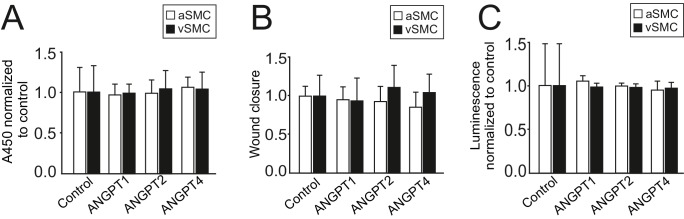
Smooth muscle cell proliferation, migration or apoptosis is not affected by ANGPT4.(A) ANGPT4 does not affect proliferation of aSMCs (n = 5 independent experiments) or vSMCs (n = 3) in BrdU ELISA. (B) ANGPT4 does not affect migration of aSMCs (n = 3) or vSMCs (n = 4) in scratch assay, bars represent wound closure time/wound area normalized to control. (C) ANGPT4 has no effect on aSMC (n = 3) or vSMC (n = 2) apoptosis in Caspase 3/7 ELISA.